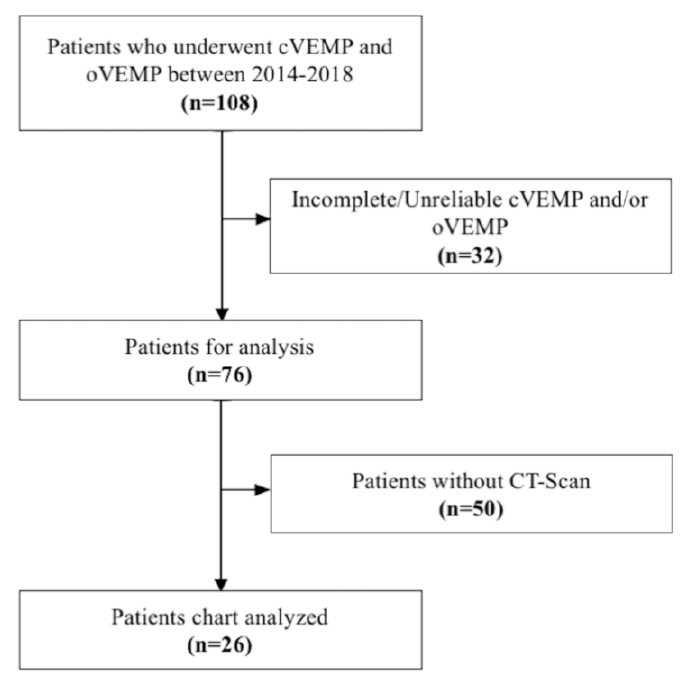
Figure 1. Flowchart representing the selection of the participants from the original database.